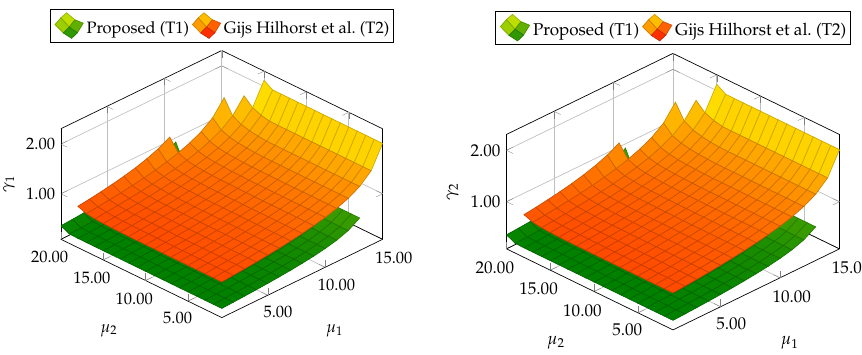
( z ) G e ∞ < µ 2 , f ˜ ε (cid:107) (cid:107)